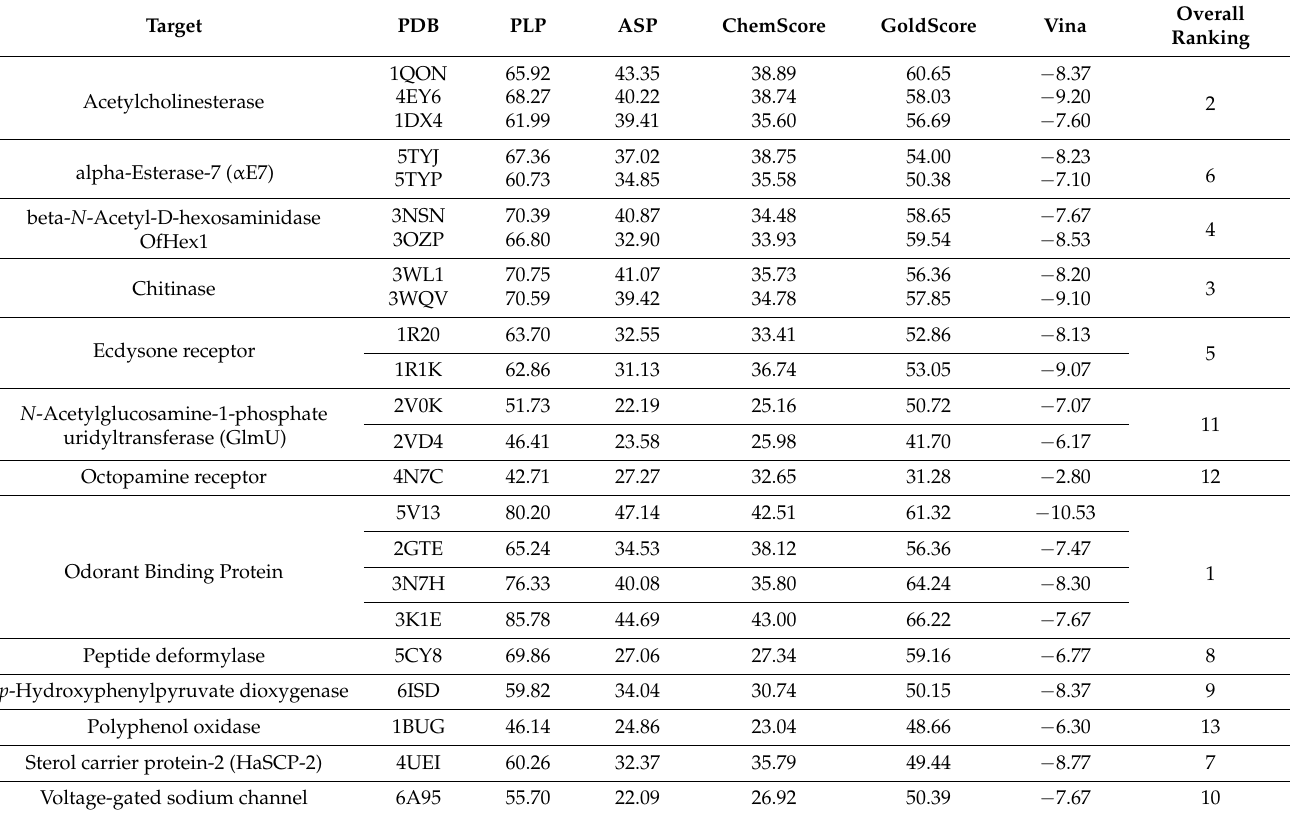
Table 2. Average scores obtained with the five different scoring functions used and overall